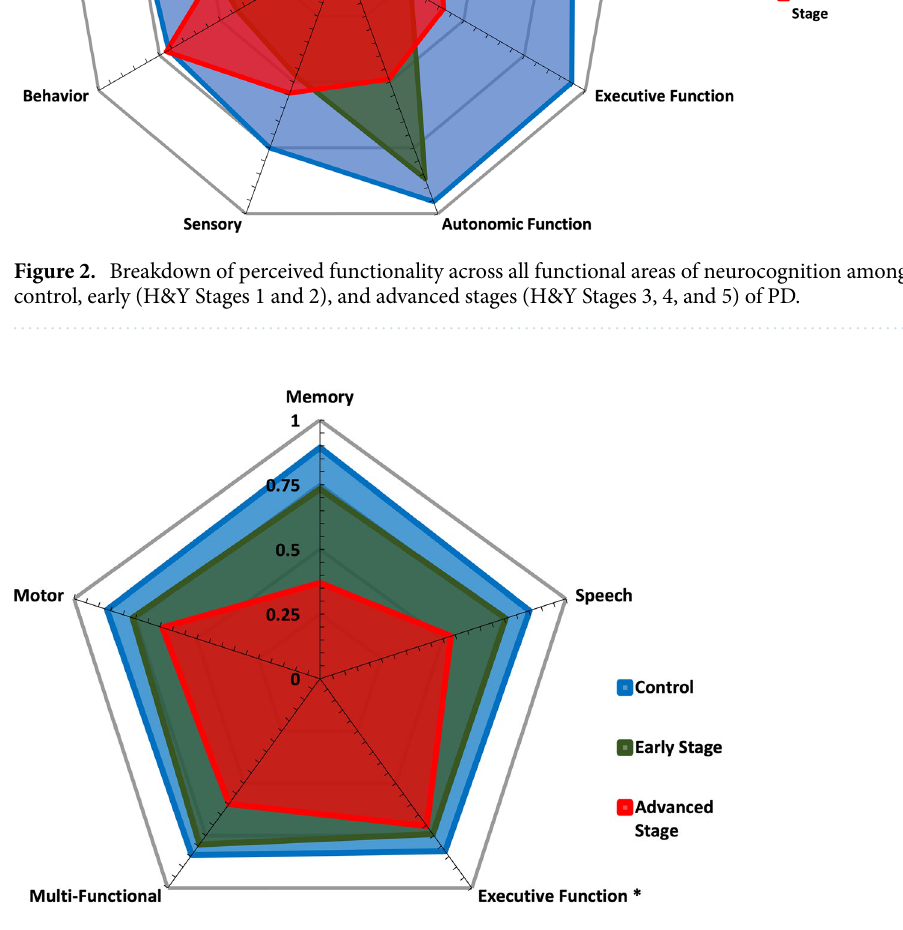
Figure 3. Breakdown of sensor-based functionality scores across motor, memory, speech, executive function, and multifunctional areas of neurocognition among groups of control, early (H&Y Stages 1 and 2), and advanced stages (H&Y Stages 3, 4, and 5) of